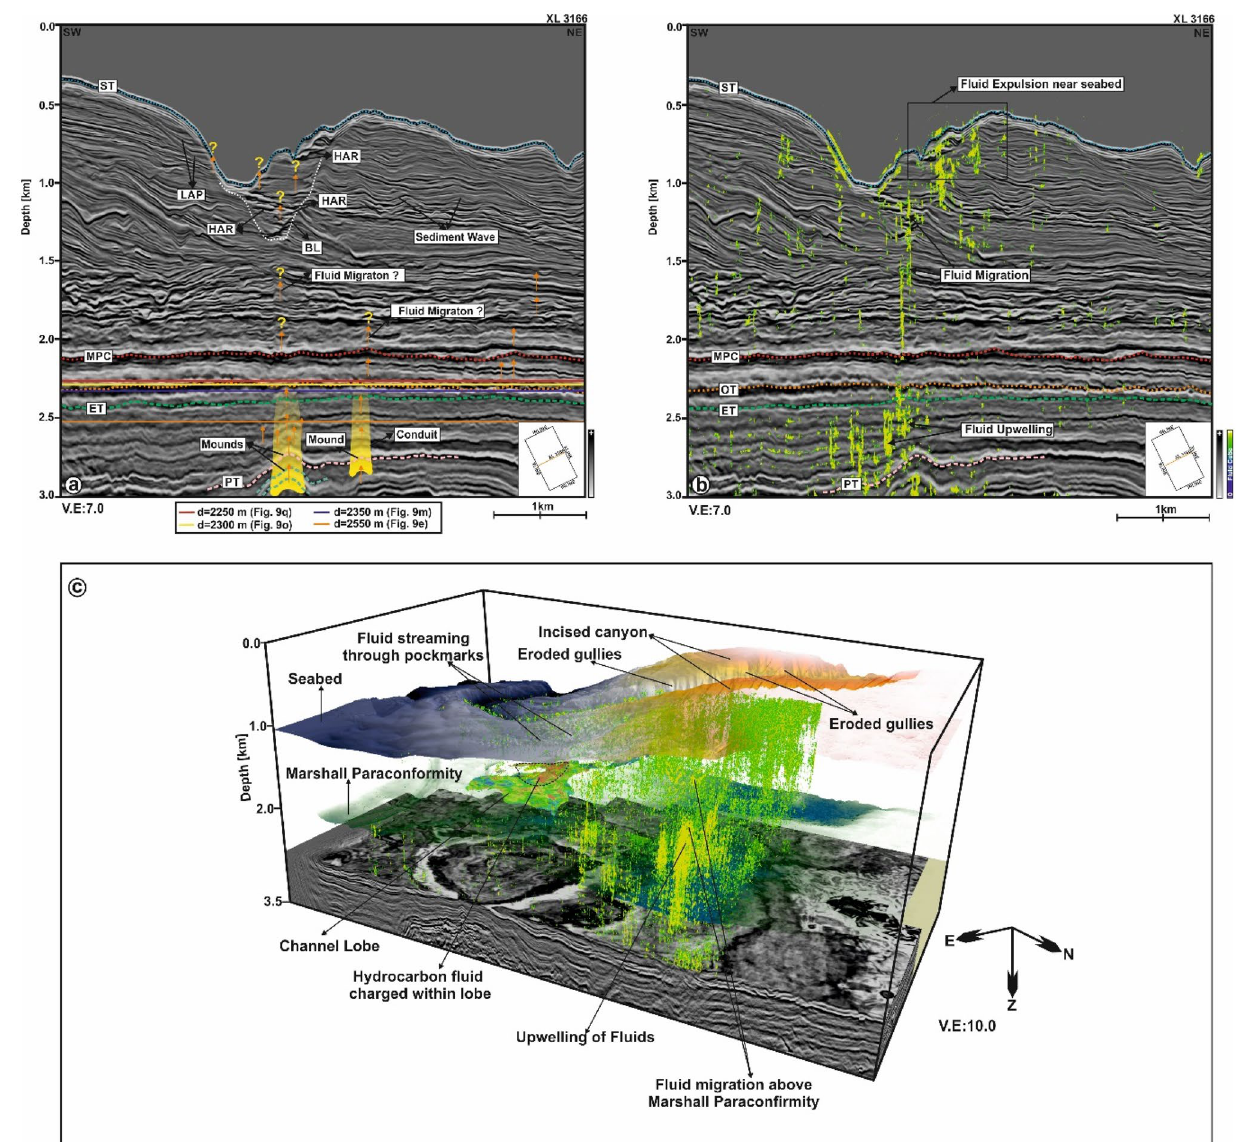
Figure 10. ( a ) Interpreted seismic line XL 3166 revealing fluid seepage from Cretaceous to Palaeocene, Eocene and Oligocene strata. Fluid is proposed to seep through different mounded structures observed within these intervals. However, above the MPC fluid seepage activity is not clear. The presence of high-amplitude seismic reflections within the basal lag bellow the canyon thalweg and pull-up reflections observed in Fig. 6 provides an hint for fluid migration through shallow strata all the way to the seafloor; ( b ) Fluid cube meta-attribute intelligently strengthens the proposition in ( a ) by presenting a realistic interpretation of fluid migration from deeper sediments into the shallower intervals i.e., through the canyon walls all the way to seafloor; ( c ) 3D view of fluid expulsion from the Paleogene sediments through the Neogene intervals into the present day seafloor. The 3D visualisation reveals the presence of shallow reservoirs i.e., channels and lobe complexes that acts as repository for the migrated fluids. ( LAP lateral accretion package, HAR high amplitude reflection, BL Basal Lab, MPC Marshall Paraconformity, PT Paleocene Top, OT Oligocene Top, ET Eocene Top, ST Seabed Top). (The above maps are prepared using licensed version of Corel Draw v16 and OpendTect interpretation Suite